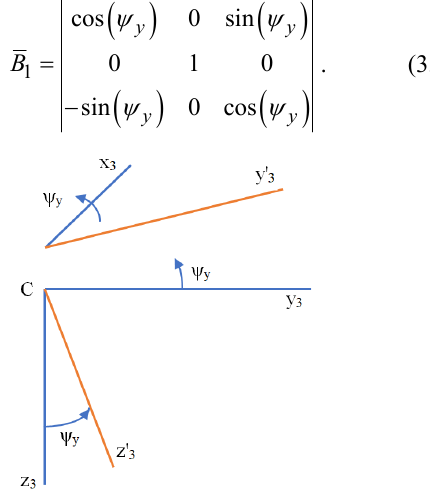
Figure 14. Scheme of the first rotation around the axis Cx 3 at the angle ψ y